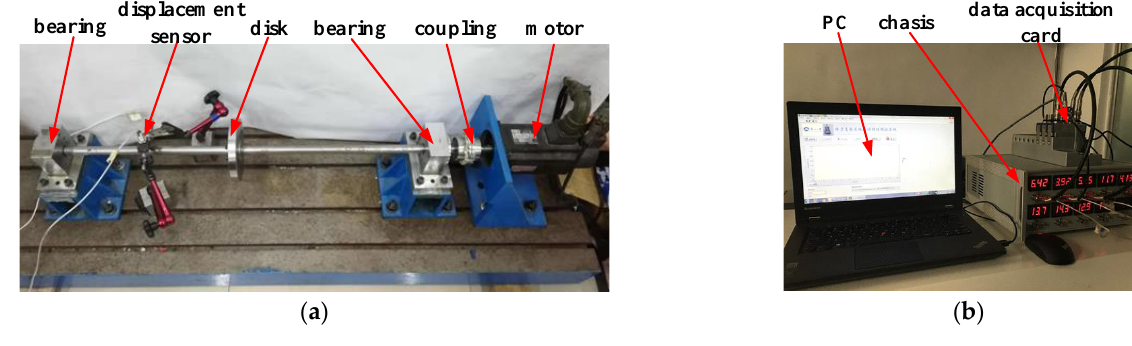
Figure 11. Experimental setup: ( a ) rotor-bearing test rig; ( b ) test system. Table 5. The modeling results of the rotor test rig in Figure 11.